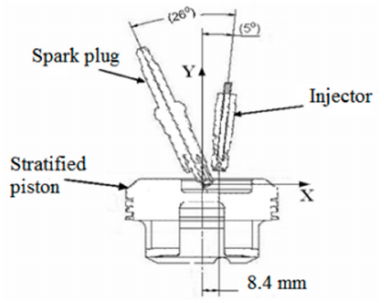
Figure 11. A schematic of the stratified piston position at top dead center